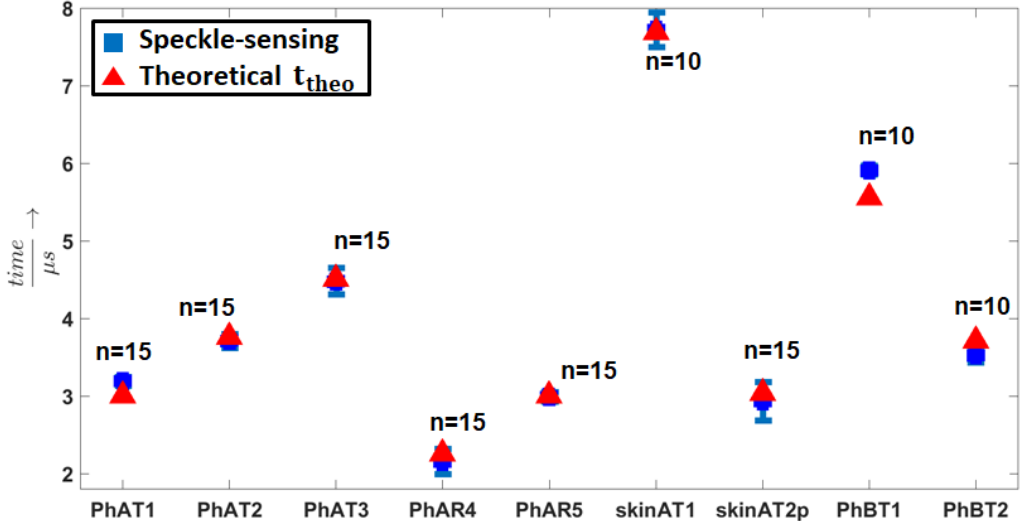
Figure 9. Mean detection times ( t mean ) and their standard deviation σ for the photoacoustic measurements. The sample names can be explained as follows: Ph stands for a phantom, A for the free-space setup, B for the fiber based setup, T for transmission mode, R for reflection mode, and p for pulsed speckle illumination below the MPE. The theoretical transit time of the photoacoustic signal is used for verification.